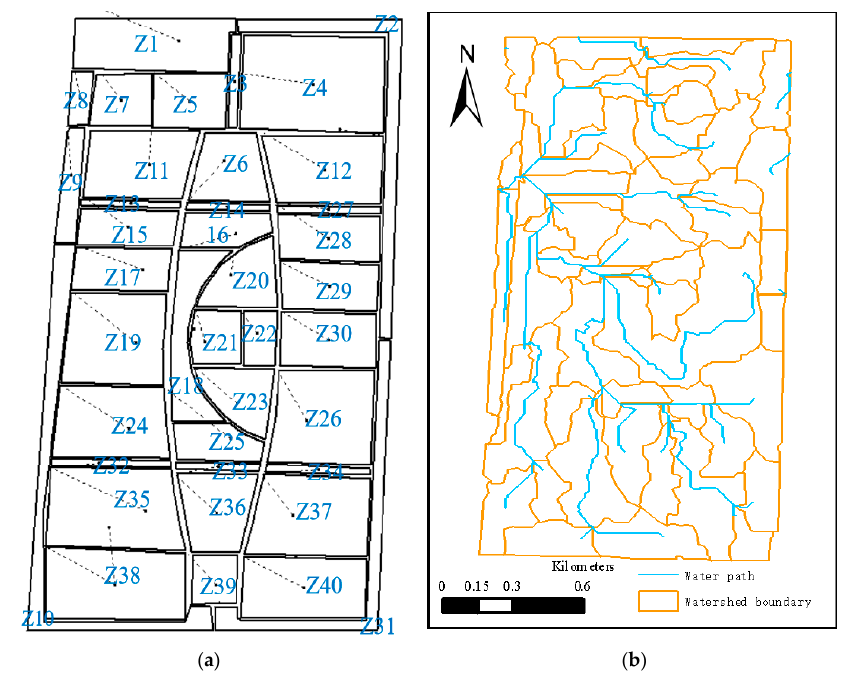
Figure 7. Subcatchment area divided according to “road-pipe network” and sub-watershed area divided according to the Digital Elevation Model (DEM). ( a ) Subcatchments bounded by road-pipe network and waters; ( b ) Subcatchments based on DEM.